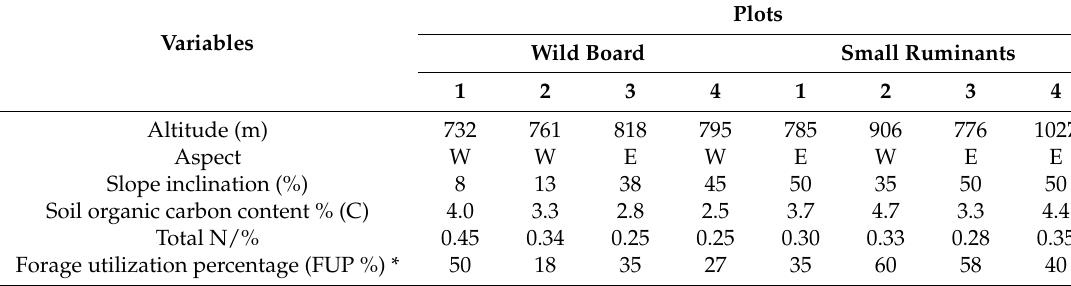
Table 2. General description of the plots in the study